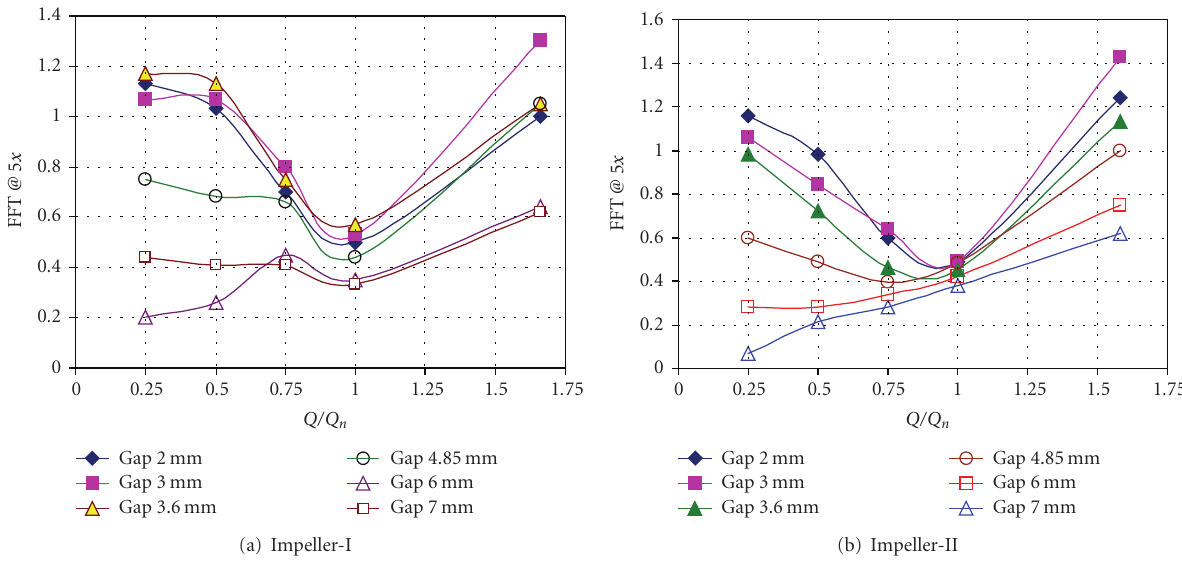
Figure 9: Variation of FFT magnitudes of pressure fluctuations with radial gap at di ff erent flow rates at location 4.